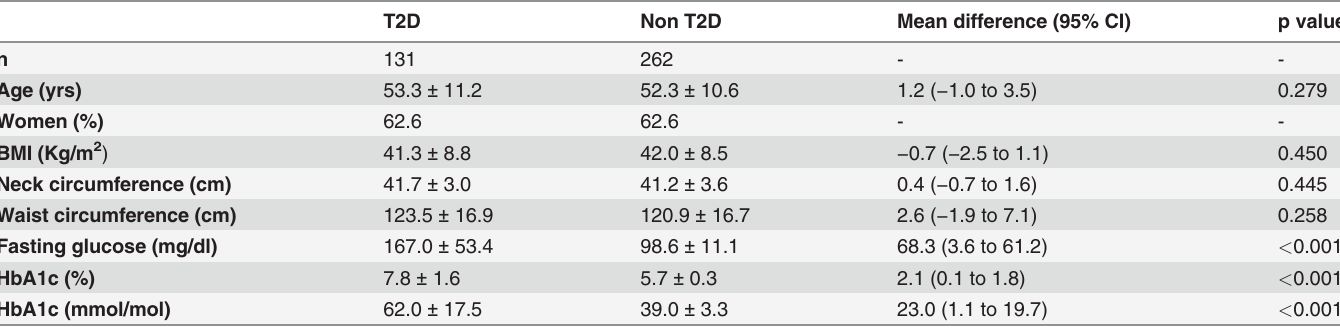
Table 1. Main clinical characteristics and metabolic data of participants included in the study according to the presence of type 2 diabetes.